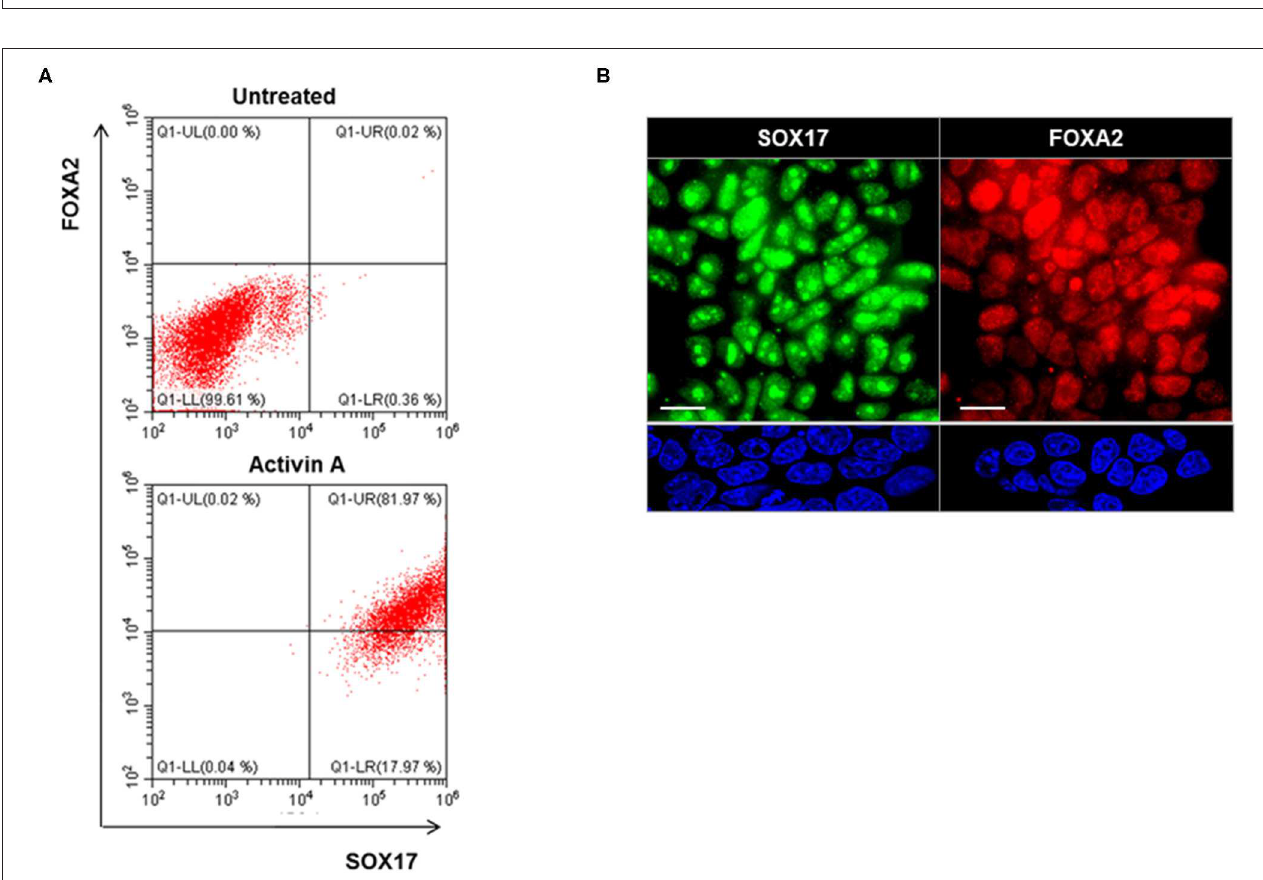
FIGURE 3 | Endoderm induction in human iPSCs (LF cells). (A) Representative flow cytometry of SOX17 and FOXA2 expressing cells in activin A treated (lower) and untreated (upper) cells. Data were representative of three separate experiments on LF cells treated with activin A for 4 days. (B) Representative images of immunostaining for endoderm markers, SOX17 (Green), and FOXA2 (Red), in in activin A treated LF cells for 4 days (upper panel) and untreated cells (lower panel). Scale bar = 20 µ m.